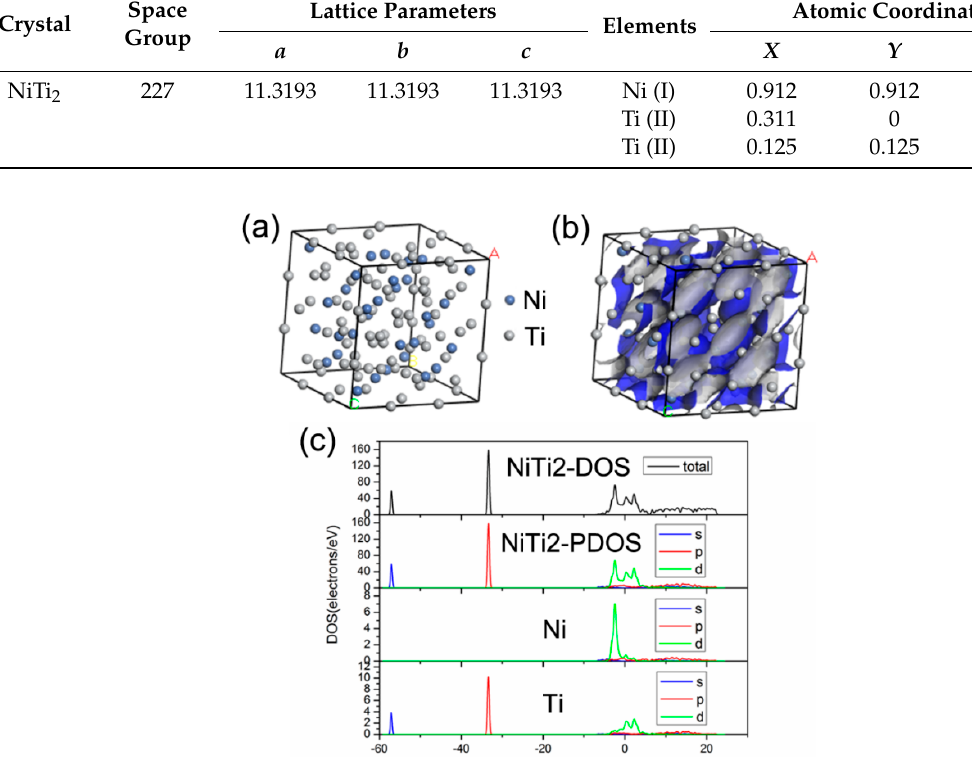
Table 2. Lattice parameters of NiTi 2 .